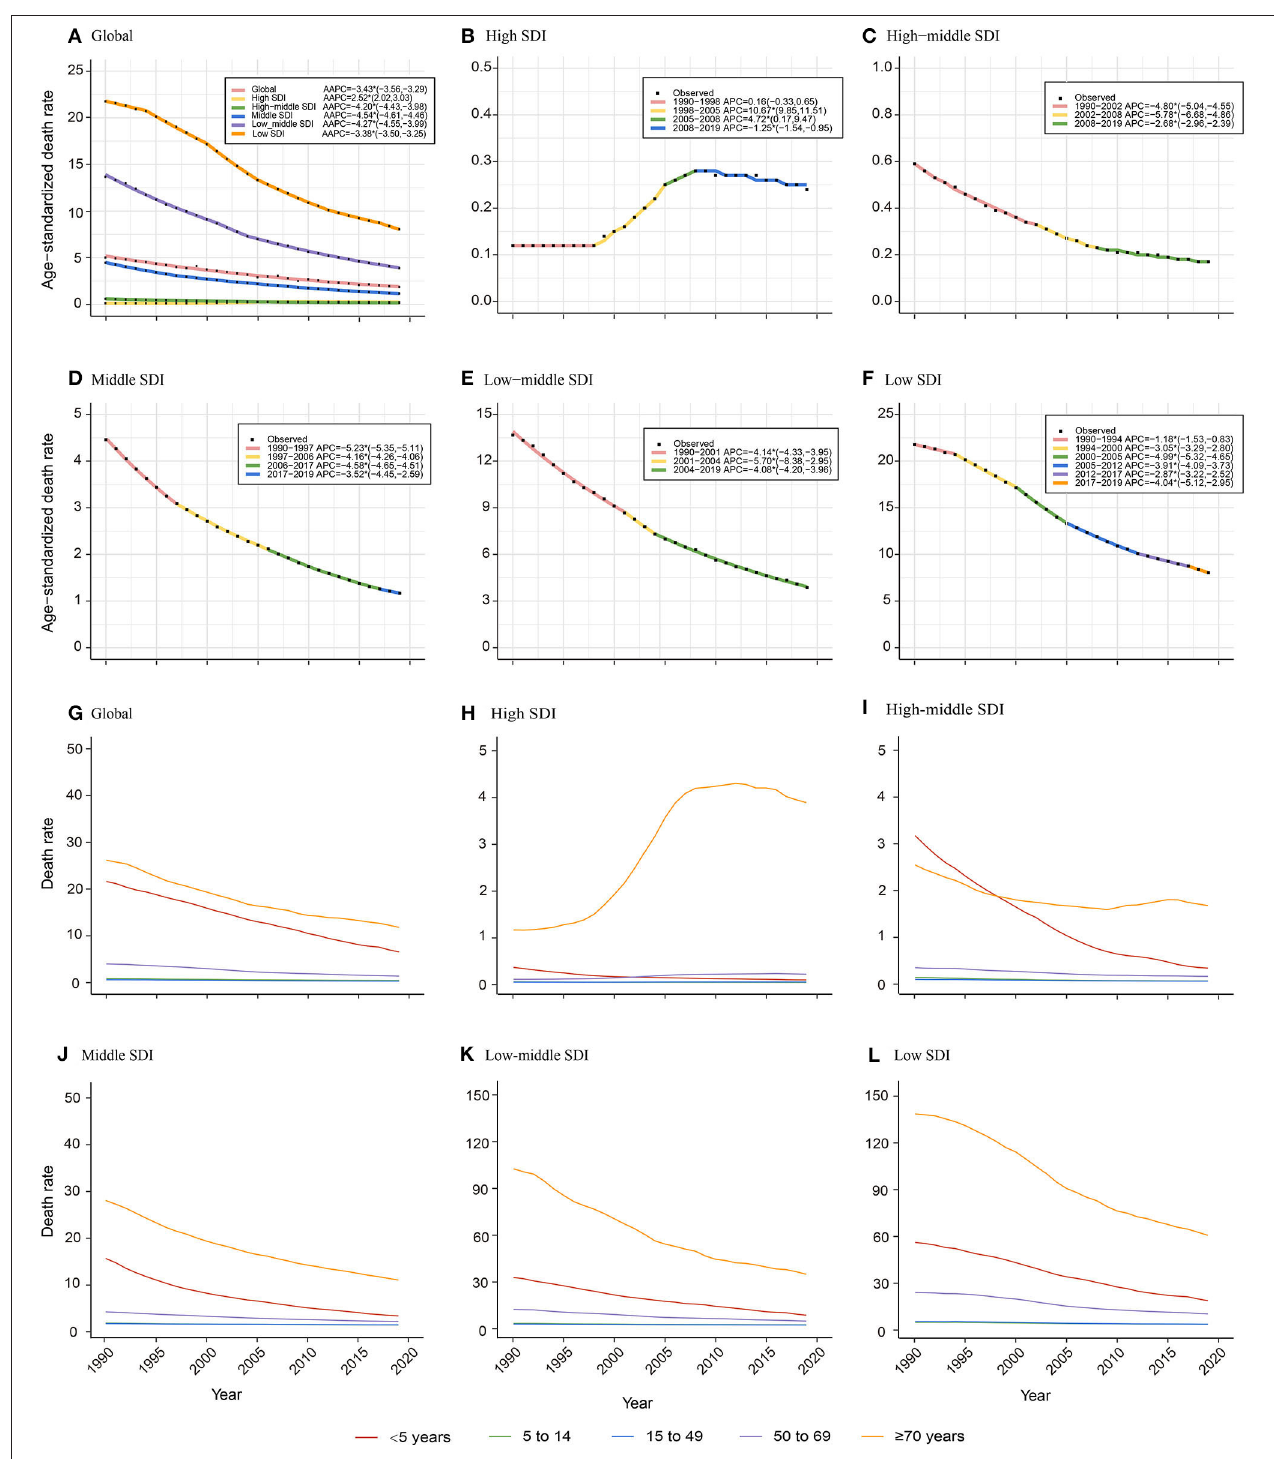
FIGURE 2 | Age-specific temporal trends of ASDR globally and in different Socio-Demographic Index (SDI) regions over 30 years old. (A–F) Temporal trends of ASDR globally and in different SDI regions; (G–L) Age-specific temporal trends of death rate globally and in different SDI regions. The APCs with asterisks (*) are statistically significant ( P <